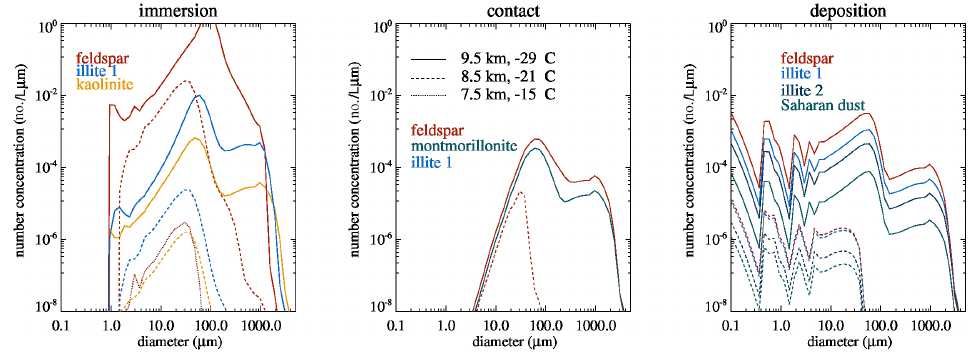
Figure 10. Development of ice particle numbers with altitude and corresponding temperature, marked by different line styles, for deposition, contact and immersion freezing. Types of INP marked by colors. Model simulations with average continental number size distribution and with (cid:49)T = 2K. Number concentrations per L and µm as a function of particle